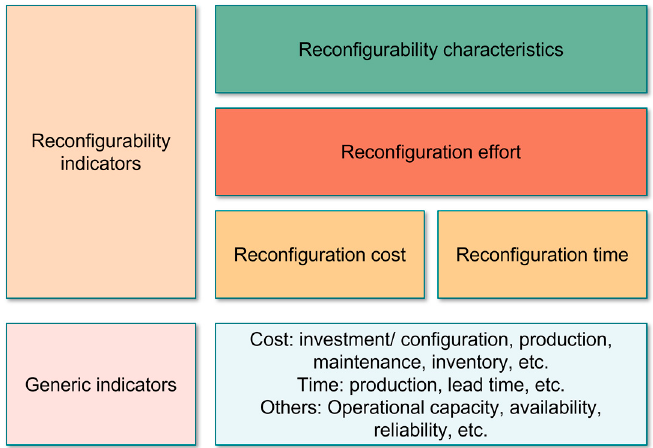
Figure 1. Classification of the configuration selection criteria.